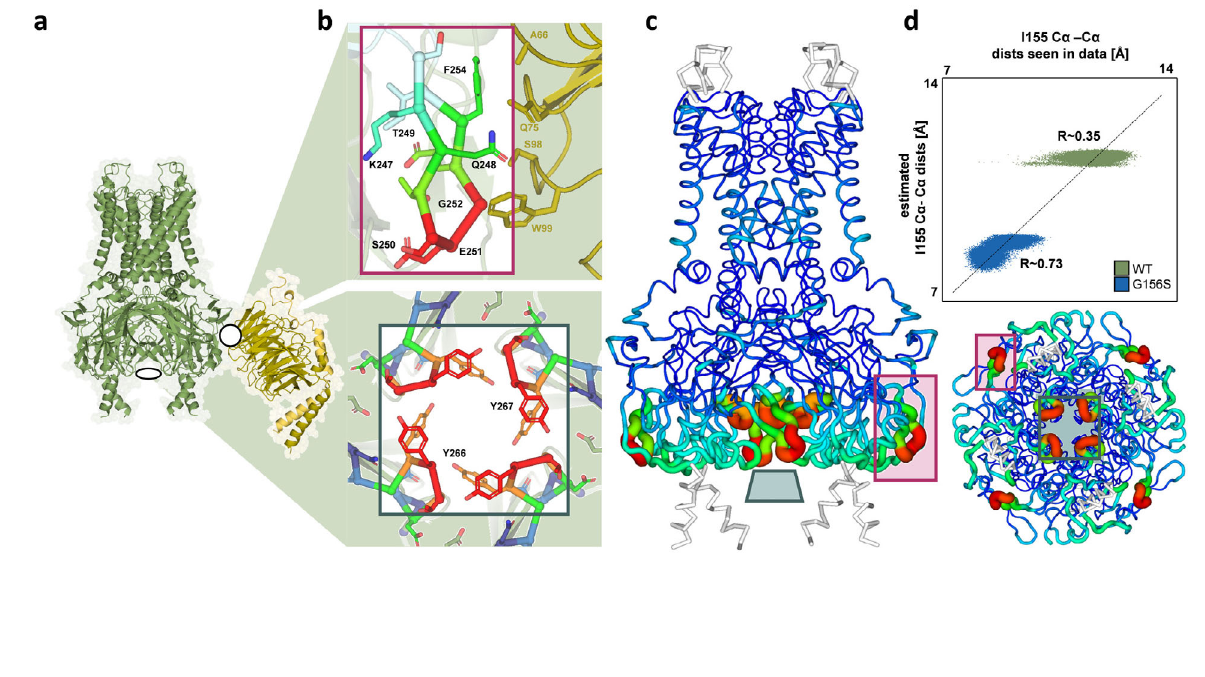
Fig. 7 Functional mode analysis (FMA) of the aberrant SF fl uctuations at I155 of mGIRK2 wv . a G βγ -bound mGIRK2 wt according to the 4KFM crystal structure. mGIRK2 is shown in green, one G βγ subunit is shown in shades of orange. b Close-ups of the two regions, which were seen to be most affected in the FMA model. The top fi gure depicts a side view of the G βγ -binding site. The lower fi gure shows a bottom-up view of the inner loops of the CTD. The colors of the residues correspond to the colors allocated in the FMA model in ( c ). c Correlations predicted by the FMA model projected on the side (left) and on the bottom-up (bottom right) view of mGIRK2. The backbone of mGIRK2 is shown in rainbow colors. Red indicates a high correlation of movements in the respective region to the C α distance fl uctuation of I155, while blue indicates no correlation. White parts were not considered in FMA model calculation. The close-ups shown in b are indicated with purple and cyan rectangles for the G βγ binding site and the inner loops of the CTD, respectively. d Validation plot of the FMA of MD simulations with the mGIRK2 wt and mGIRK2 wv